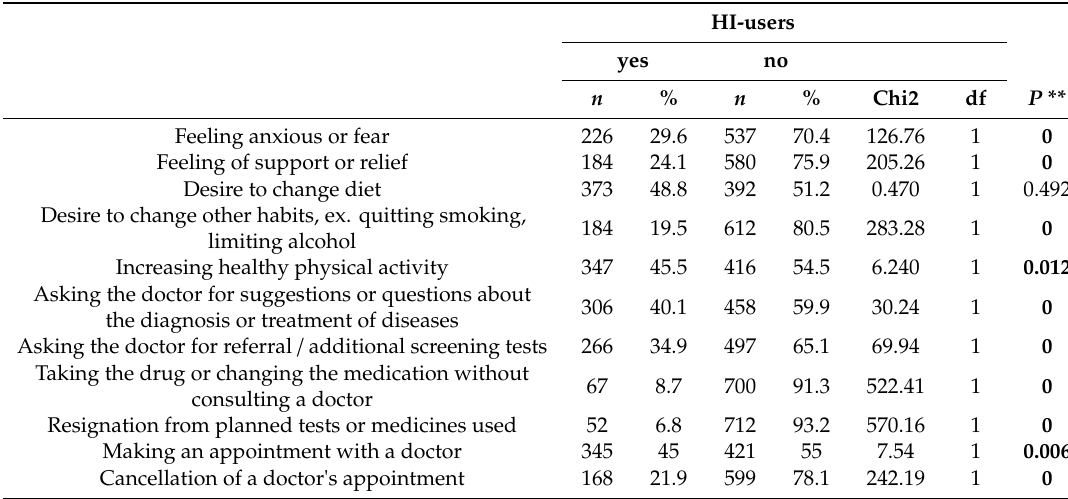
Table 3. Emotions, health intentions and self-reported health decisions caused by online health-related information